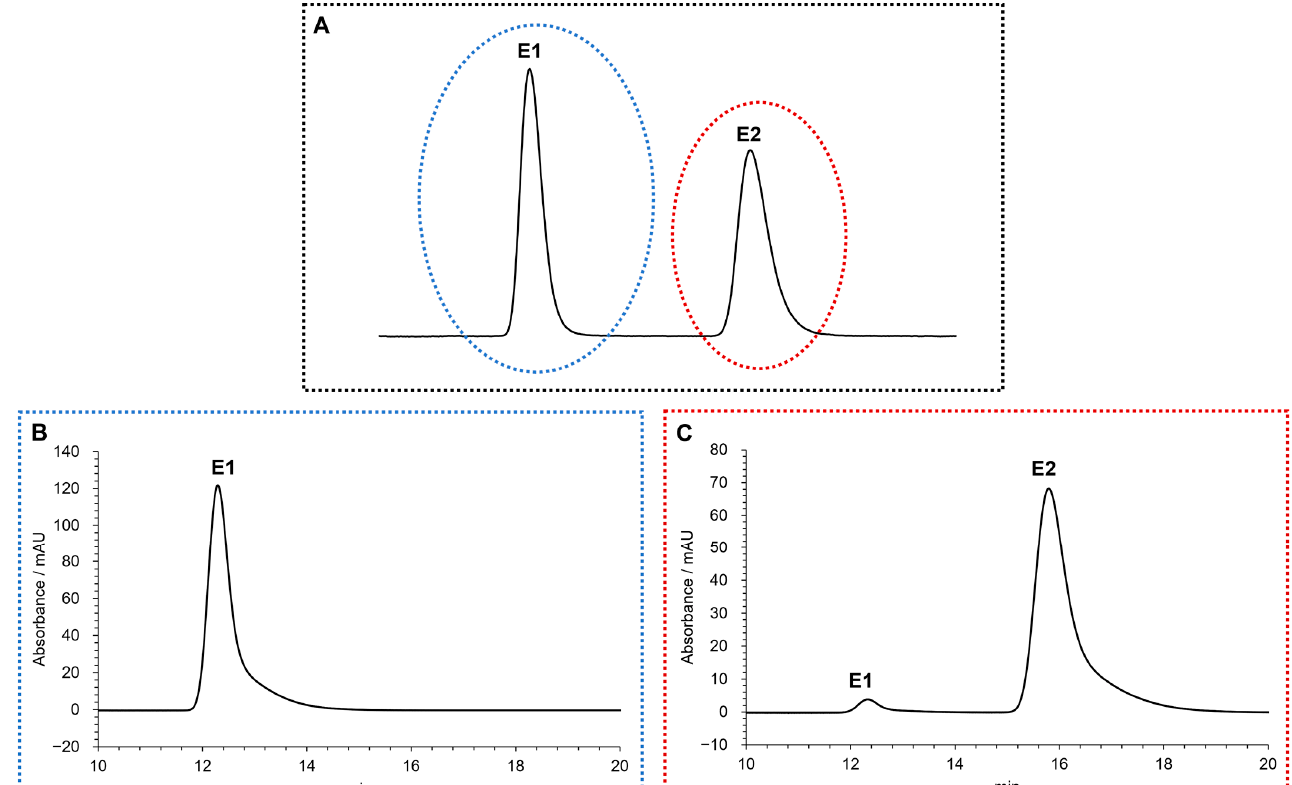
Figure 3. Chromatographs of MDPV racemate ( A ), E1 ( B ) and E2 ( C ). Chromatographic conditions: Lux Amylose-I ® column; mobile phase: Hex:EtOH:DEA (97:3:0.1 v / v / v ); flow rate: 1 mL/min; UV detection: 254 nm.